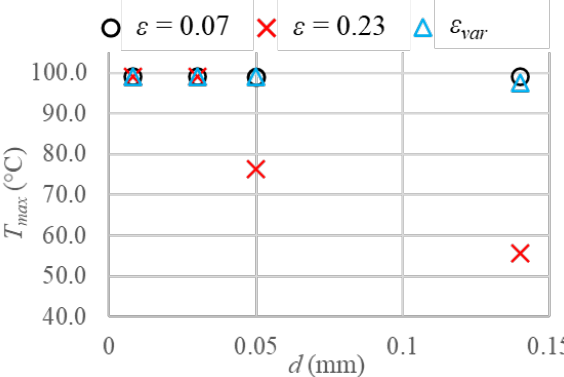
Figure 6. Maximum tissue temperature values reached considering the three different porosities and the four blood vessels investigated.